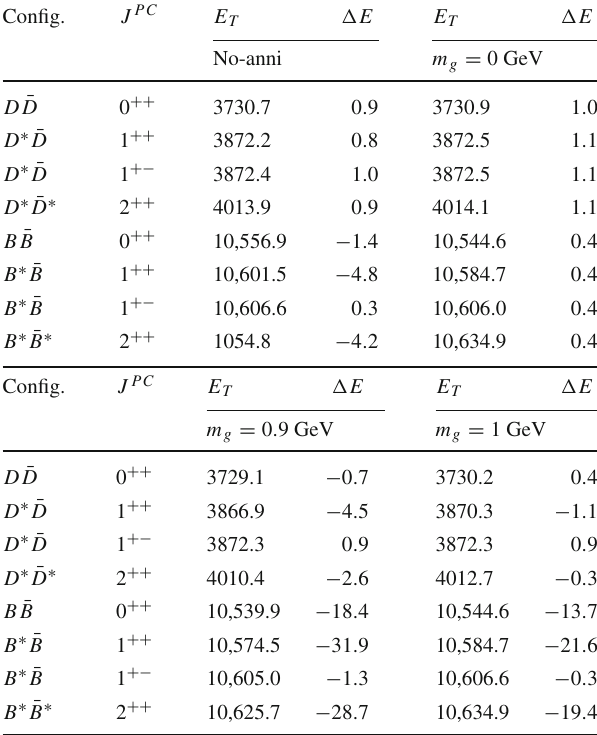
Table 7 Same as Table 5 for the ChQM with new parameters Config.